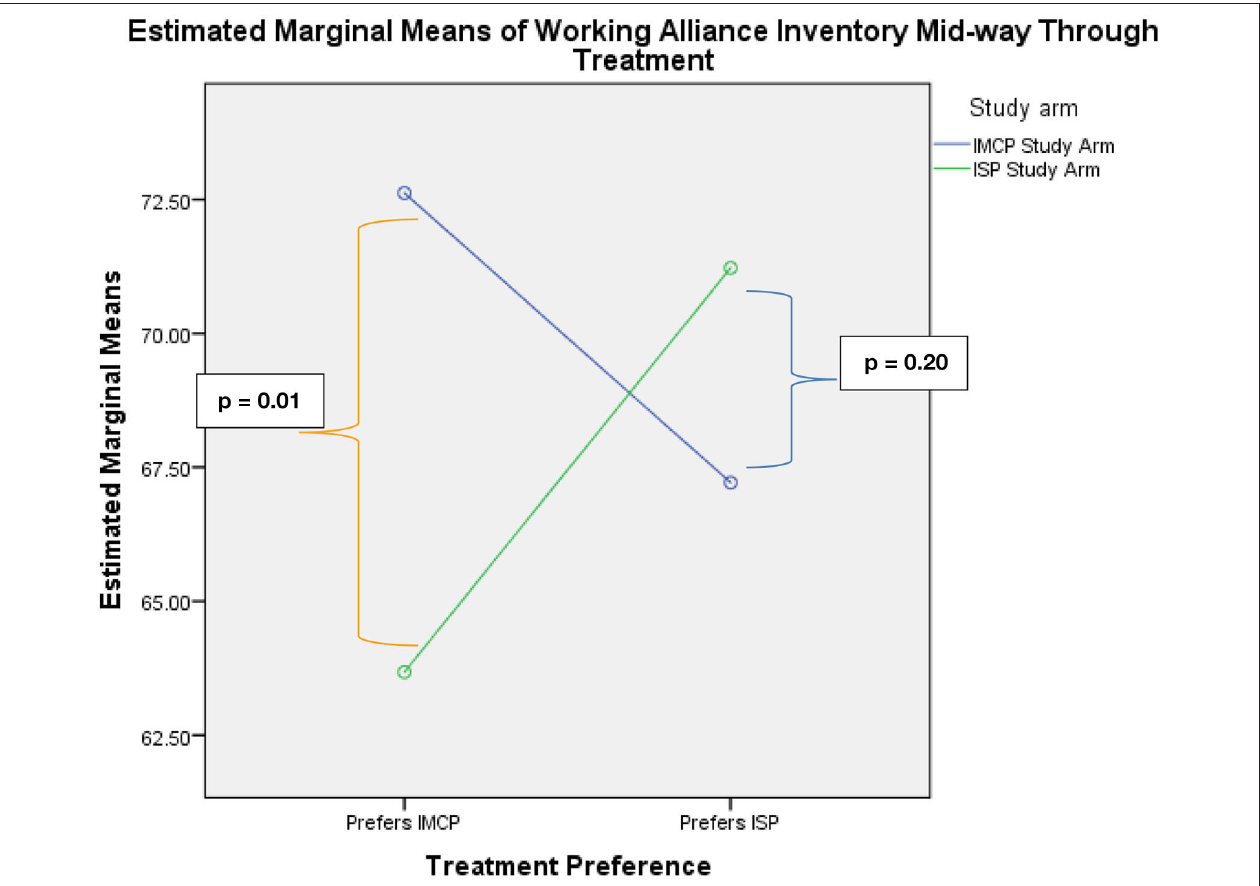
FIGURE 1 | Significant crossover interaction and pairwise comparisons indicating a significant difference between patients who prefer and receive IMCP and those who prefer IMCP and receive